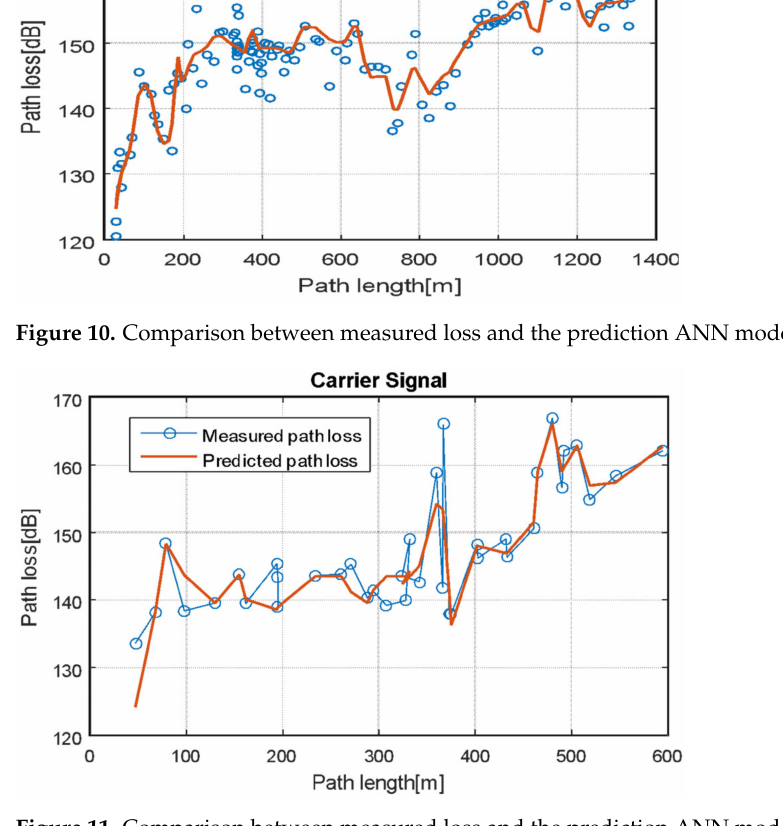
Figure 11. Comparison between measured loss and the prediction ANN model in site 3.